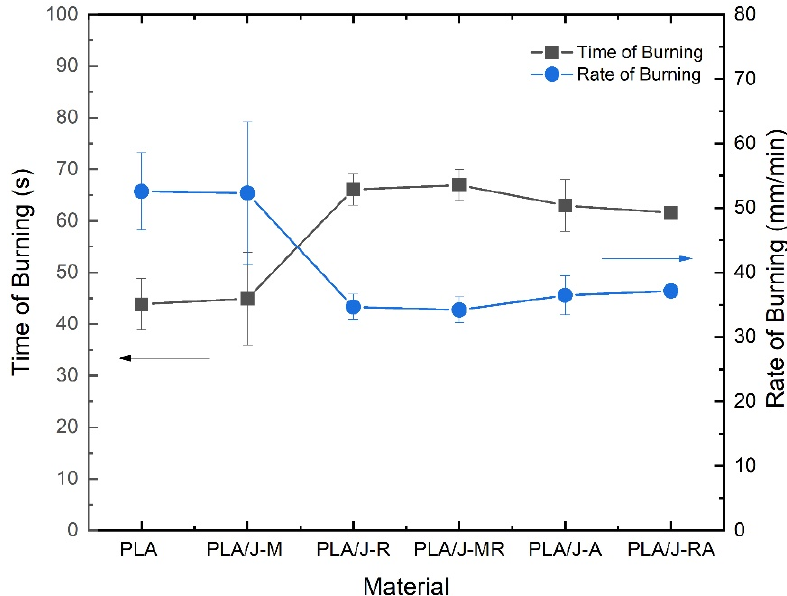
Figure 6. Time and rate of burning obtained for PLA and PLA composites.